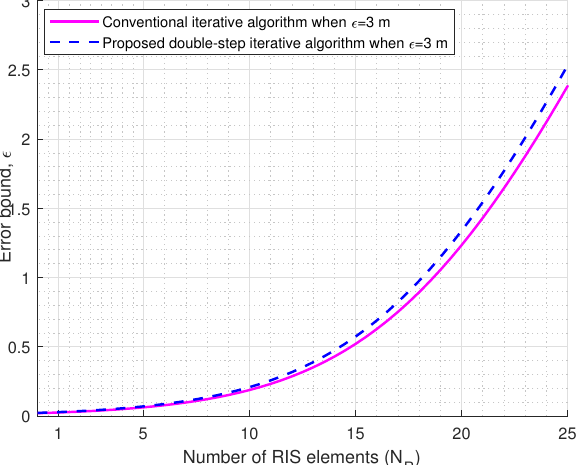
Figure 9. Channel state information error bound versus the number of RIS